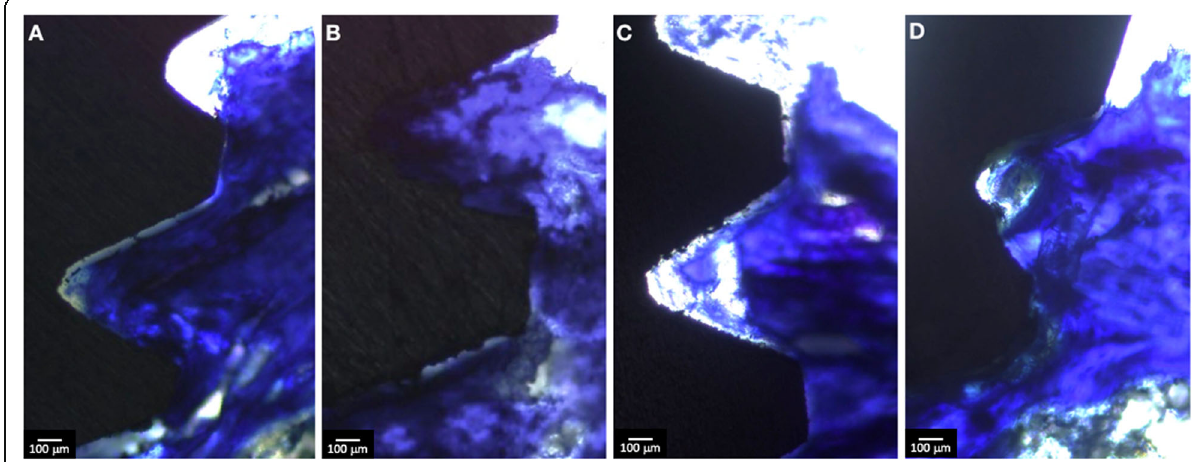
Fig. 3 Histological findings of low-dose aspirin regarding bone deposition in titanium surface. Samples of AG-7 ( a ), AG-28 ( b ), CG-7 ( c ), and CG-28 ( d ) groups were embedded in a methacrylate-based resin and submitted to histological evaluation with toluidine blue